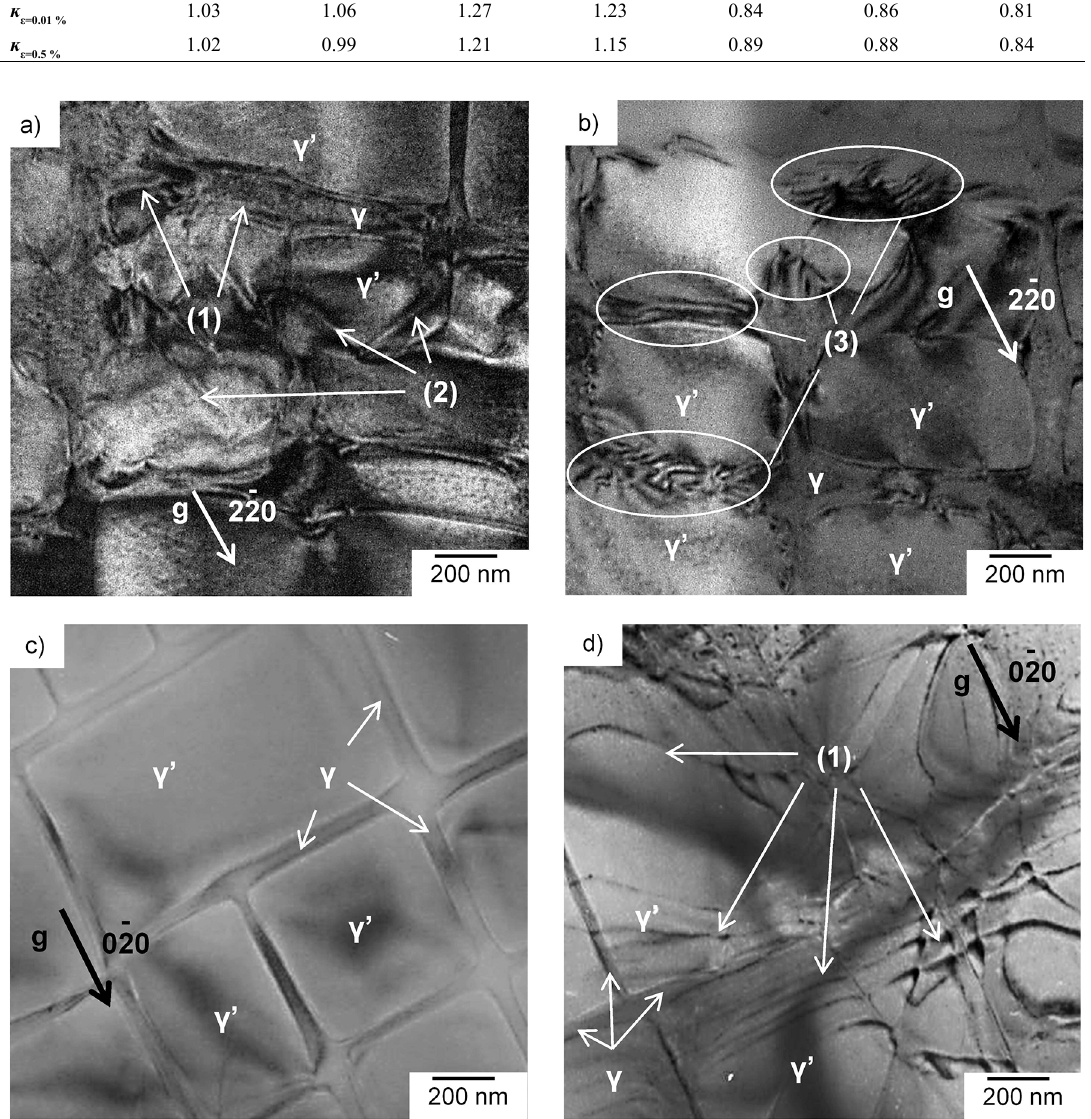
Figure 6. TEM images of lamella prepared by focused-ion beam cutting from creep deformed CMSX-4 (ɛ = 0.5 %): a) prior to and b) after current-impulse treatment, and TEM images of a heat treated specimen of CMSX-4: c) prior to and d) after current-impulse treatment (test parameters according to Table 3 ); with (1) interfacial dislocations, (2) super dislocations and (3) interaction between (1) and